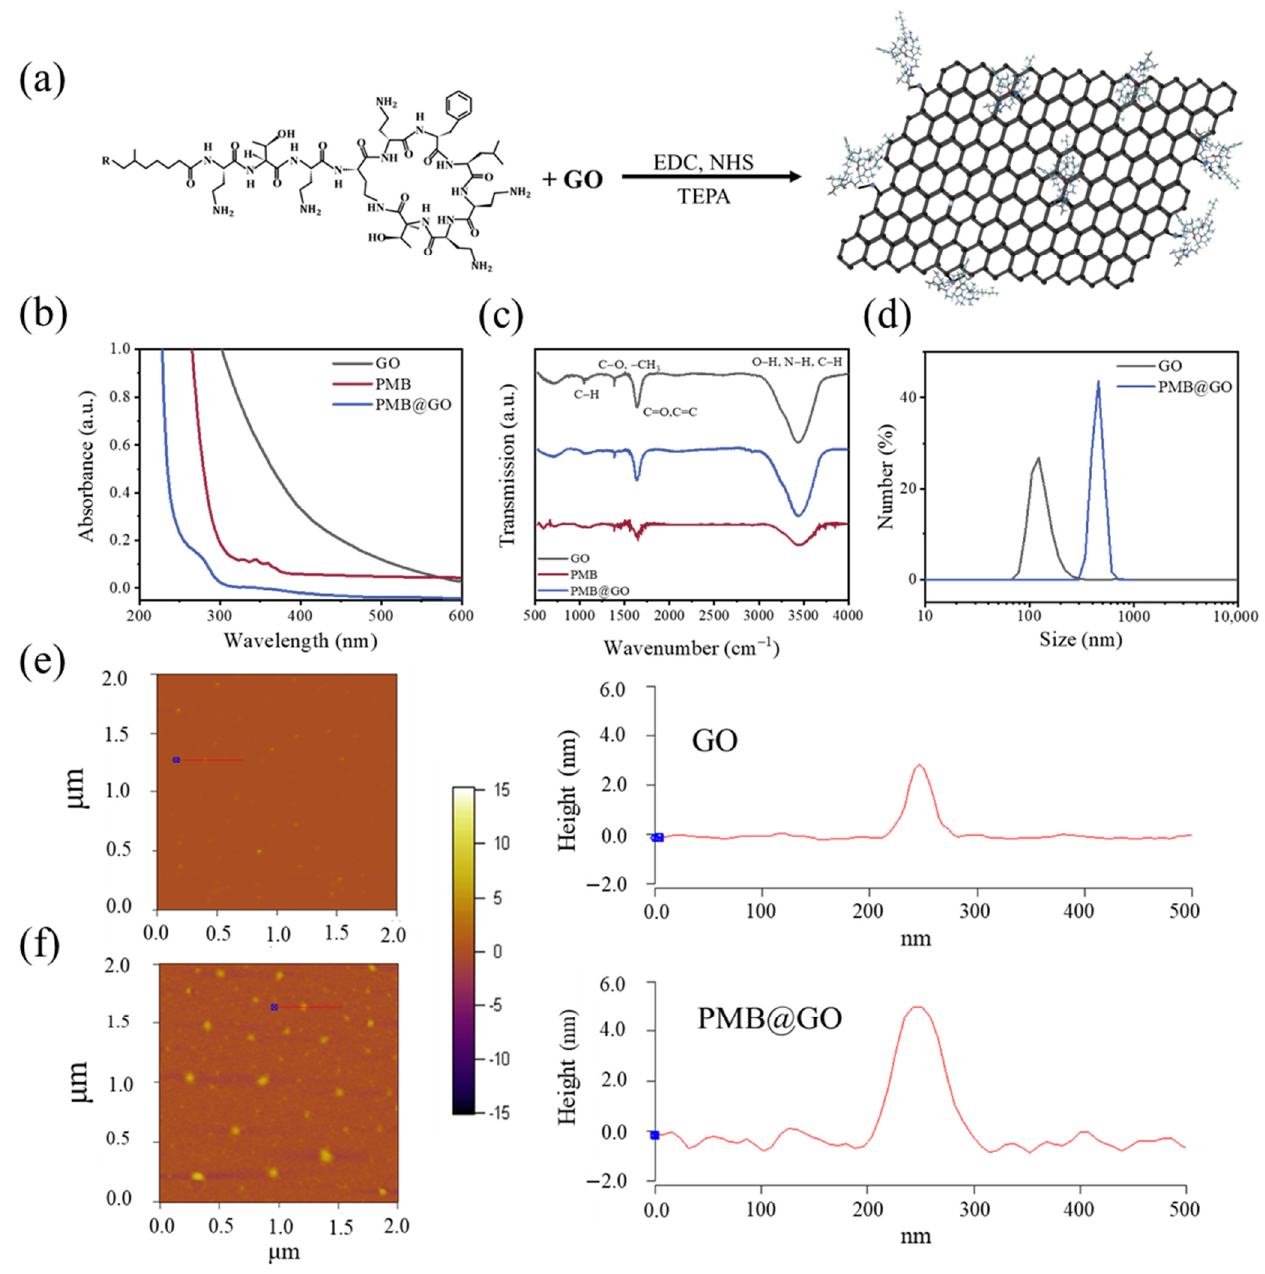
Figure 1. Synthesis and characterization of PMB@GO nanocomposite. ( a ) Chemical structure formula of PMB and schematic diagram of the PMB@GO nanocomposite synthesized by the EDC/NHS crosslinking method. Tetraethylenepentamine (TEPA) was used as catalyzer. ( b – e ) UV–vis absorption ( b ), FTIR ( c ), DLS ( d ), and AFM ( e – f ) characterizations of the nanocomposite. The results of pristine PMB and GO are also shown for reference. Height profile along the red line in AFM image is shown in the corresponding right panel.